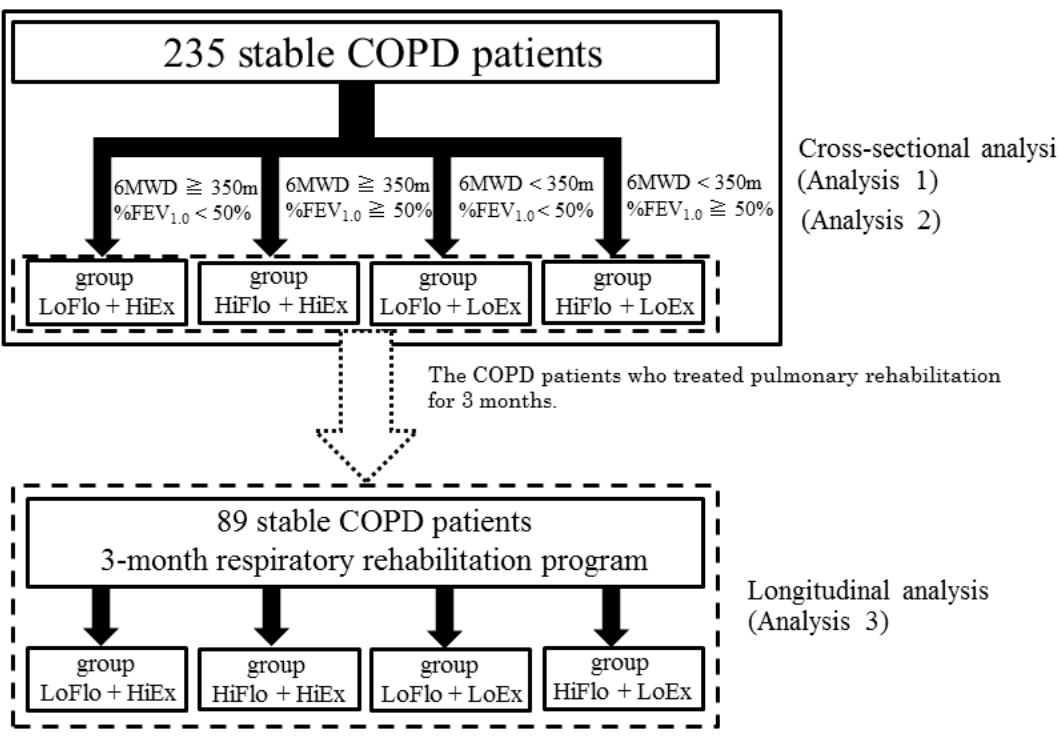
Figure 2. Study protocol. In total, 235 participants with stable COPD were assessed at baseline and divided into the LoFlo + HiEx, HiFlo + HiEx, LoFlo + LoEx, and HiFlo + LoEx groups. %FEV 1.0 , percentage of predicted forced expiratory volume in one second; 6MWD, six-minute walking distance.